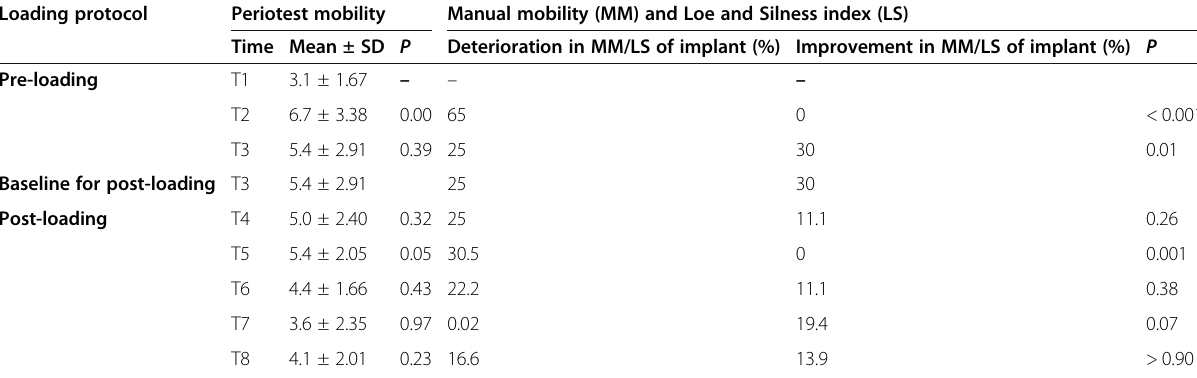
Table 3 Comparison of periotest mobility, manual mobility (MM), and modified Loe and Silness index before and after loading of